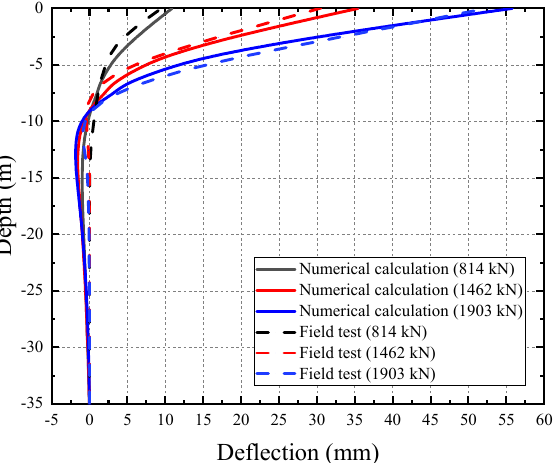
Figure 10. Comparison of the deflection results of the pile along the pile body between the field tests and the numerical simulation under different values of horizontal load.